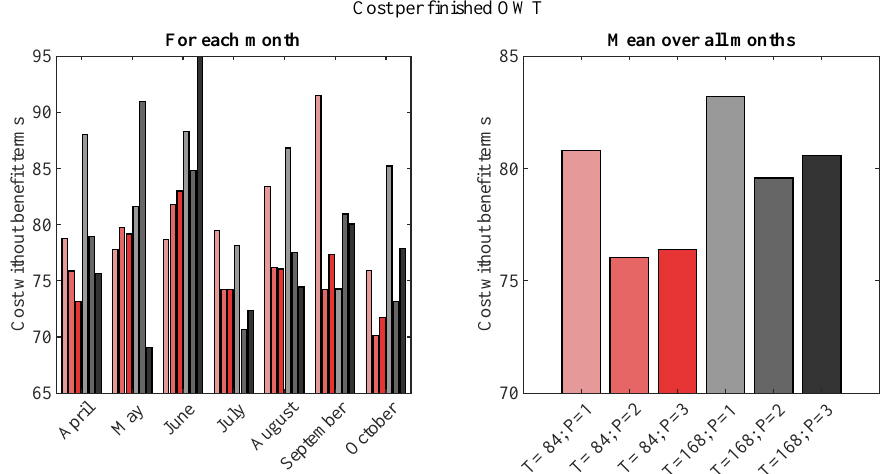
Figure 8. Cost per finished turbine as average over the scenarios for April until